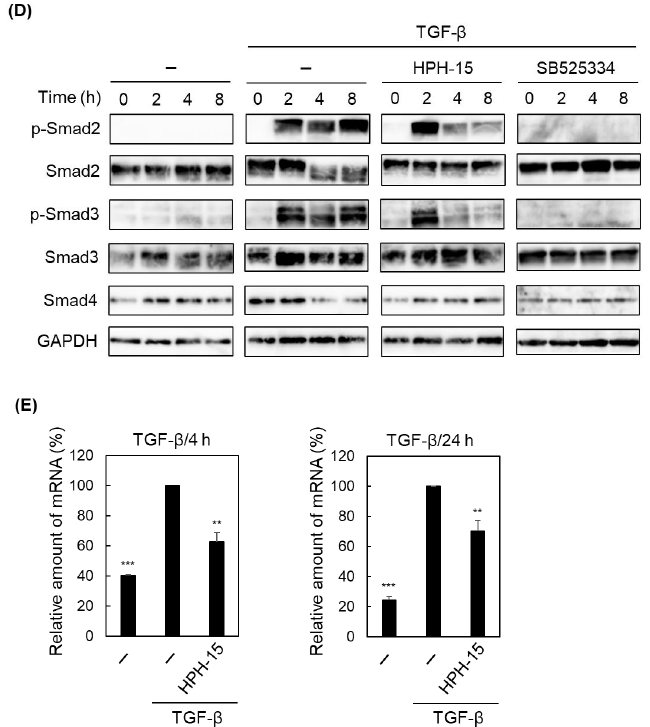
Figure 4. Effects of HPH-15 on a Smad-dependent pathway in TGF- β signaling. ( A ) The activity of a reporter product transcribed from a Smad binding promoter in A549 cells. The cells co-transfected with pGL4.48[ luc2P /SBE/Hygro] Vector (with SBE and firefly luciferase gene) and pRL-Luc (with a β -actin promoter and renilla luciferase gene for internal control) were incubated for 16 h. After the cells were incubated for another 8 h in the presence of HPH-15 (10 µ M) and TGF- β (10 ng/mL), the cells were lysed. The lysate was analyzed by a dual luciferase assay, and the values obtained were normalized. Relative values are shown. ( B ) Protein levels of phosphorylated Smad2 and Smad3 in TGF- β -stimulated A549 cells treated with HPH-15. After incubating the cells for 1 d in the presence of HPH-15 (10 µ M) and TGF- β (10 ng/mL), the cells were lysed. The lysate was analyzed by immunoblotting. ( C ) Quantification of phosphorylation of Smad2 and Smad3. The intensity of the bands in ( B ) was quantified using ImageJ. Relative values (band intensity of phosphorylated protein and that of unphosphorylated protein) are shown as values of “Relative phosphorylation of protein.” ( D ) Time course of the amounts of phosphorylated Smad2 and Smad3 proteins in TGF- β -stimulated A549 cells treated with HPH-15. After incubating the cells for the designated time in the presence of HPH-15 (10 µ M) or SB525334 (10 µ M) and TGF- β (10 ng/mL), the cells were lysed. The lysate was analyzed by immunoblotting. ( E ) mRNA levels of TGF- β 1 (TGF- β ) in TGF- β -stimulated A549 cells treated with HPH-15. After incubating the cells for 4 or 24 h in the presence of HPH-15 (10 µ M) and TGF- β (10 ng/mL), RNA was extracted from the cells, and RT-PCR was performed. Relative values are shown. ** p < 0.01, *** p < 0.001 compared with samples treated with TGF- β and without HPH-15. Next, we examined the Smad-independent pathway [12,13]. Similar to the experiment to observe the Smad-dependent pathway (Figure 4B), the phosphorylation of Akt and extracellular signal-regulated kinase (ERK) was examined (Figure 5A,B). Upon TGF- β stim- ulation, phospho-Akt increased, and virtually no phosphorylated ERK was phosphorylated. HPH-15 inhibited the phosphorylation caused by stimulation. The amounts of Akt and ERK did not change with TGF- β /HPH-15